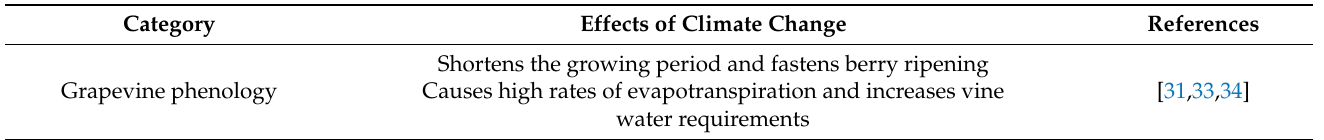
Table 1. Summary of impact of climate change on grapevines, berries, and